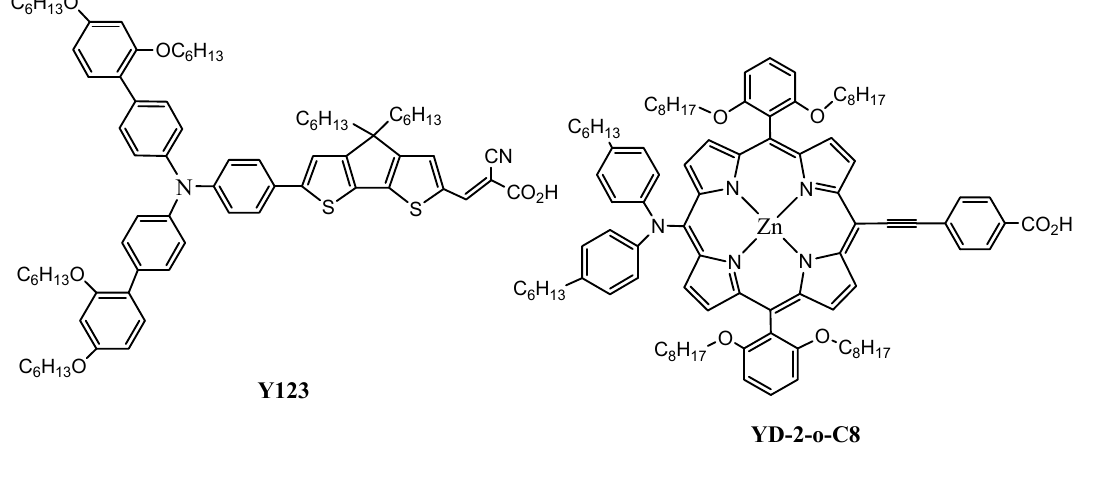
Figure 2. Co-sensitization of Y123 and YD-2-o-C8 (world record holder with a PCE >